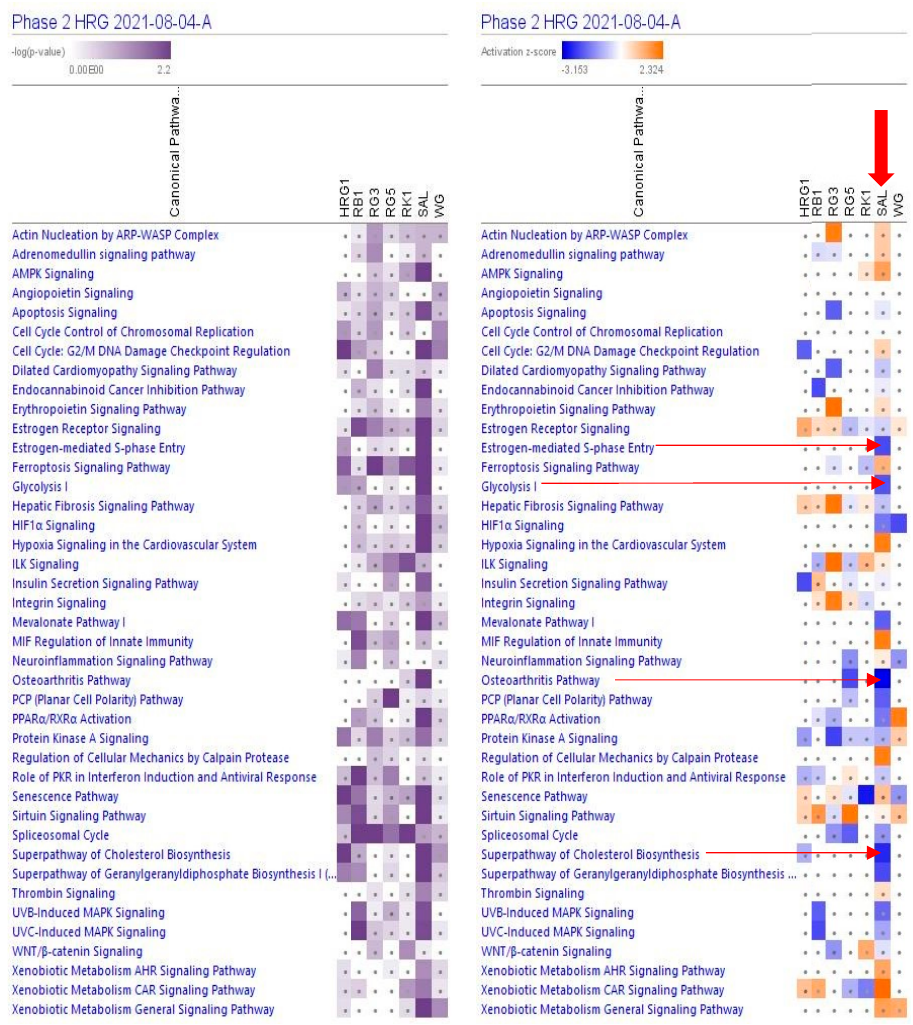
Figure 2. Effects of RG–RS (SAL) at concentrations of 20 µ g/mL, RG at concentrations of 10 µ g/mL (HRG1), white ginseng (WG), and ginsenosides Rb1, Rg3, Rg5, Rk1 at the concentration of 0.1 µ M on selected canonical pathways. The violet color shows the p -value (calculated using a